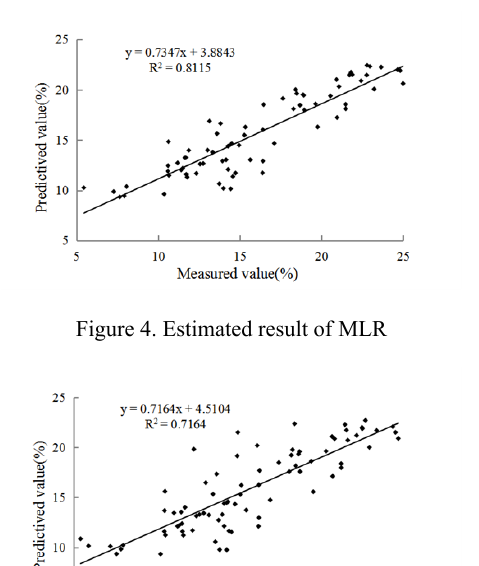
Figure 8. Estimated result of SVM